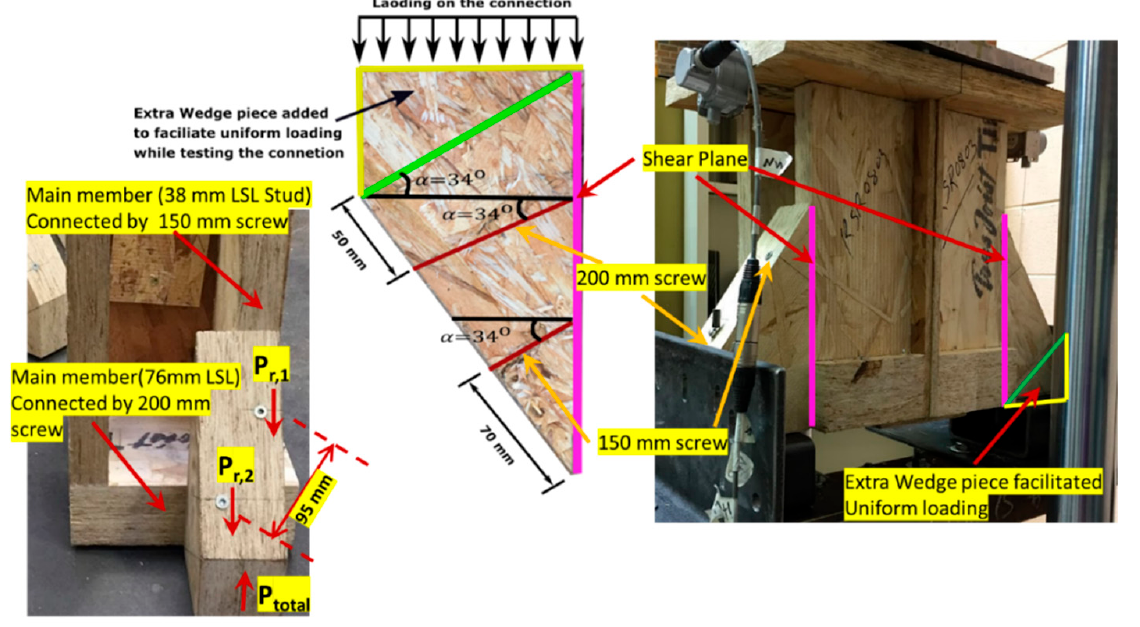
Figure 27. Support wall-to-wedge piece connection details for strength prediction.